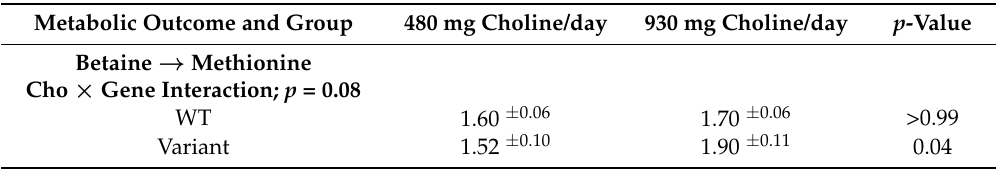
Table 17. Comparison of choline → CDP-PC turnover between SLC44A1 rs3199966 genotypes by choline intake group. Values are least-squared means ± standard errors in µ M methionine/study period.